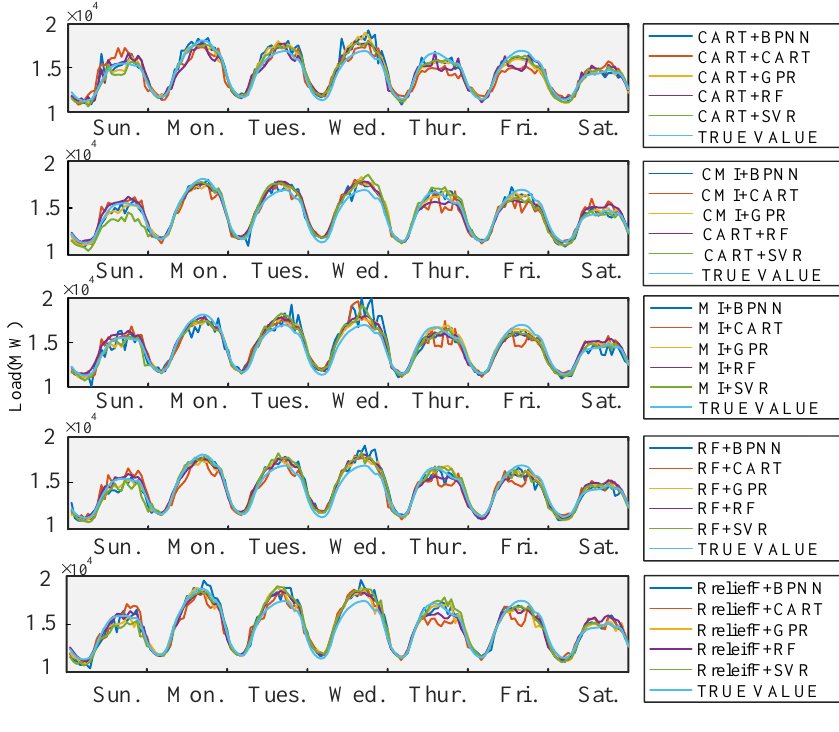
Figure 5. Prediction from 28 July to 3 August 2013. Table 6. Comparison of different combined methods.